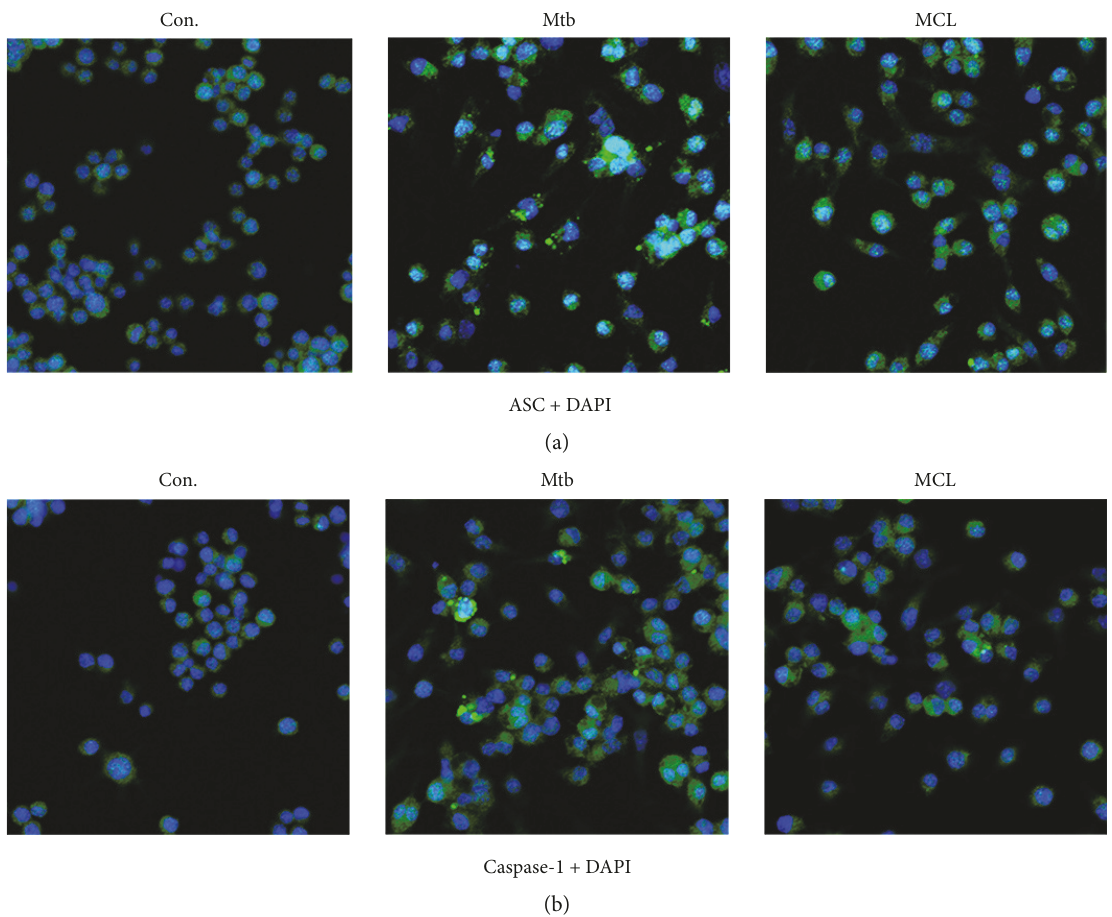
Figure 4: MCL attenuates the amount of NLRP3 in fl ammasome components in Mtb-infected Raw264.7 cell. Raw264.7 cells (1 × 10 5 /well) were seeded in 6-well plates which were precovered with cell climbing slice overnight, and the cells were infected with H37Ra as previously. Cells were then treated with MCL at the concentration of 10 μ M for 12hr. Rabbit anti-ASC (green) or rabbit anti-caspase-1 (green) antibody and DAPI (blue) were used for immunostaining assay. Images were taken with laser scanning confocal microscopy. Con. is the abbreviation of control group, which showed no e ff ect on the expression of ASC (a) and caspase-1 (b). Mtb promoted the formation and amounts of ASC specks, and the treatment of MCL reduced it apparently (a). Meanwhile, consistent with ASC, Mtb infection evidently augments the expression of caspase-1 and MCL decreased caspase-1 (b). Thus, MCL treatment apparently inhibits the activity of NLRP3 in fl ammasome. The results of (a) and (b) were obtained,